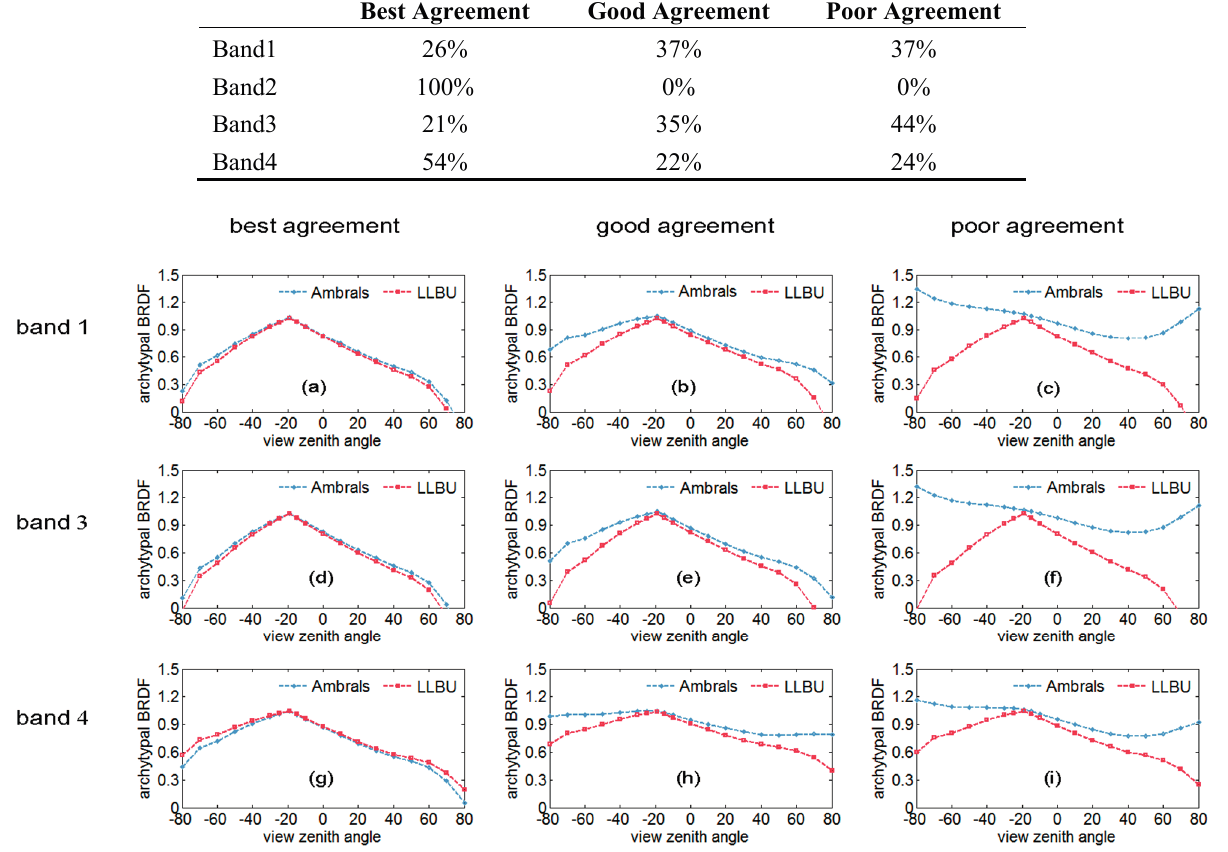
Figure 11. LLBU and AMBRALS compared in three typical situations. Columns from left to right are best agreement, good agreement, and poor agreement, respectively, and rows from top to bottom are Band 1 ( a – c ), Band 3 ( d – f ), and Band 4 ( g – i ).